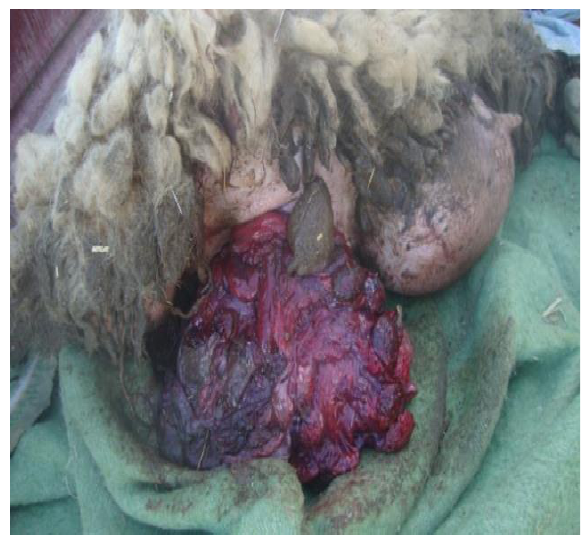
Figure, 1 : Postpartum uterine prolapse in local Iraqi